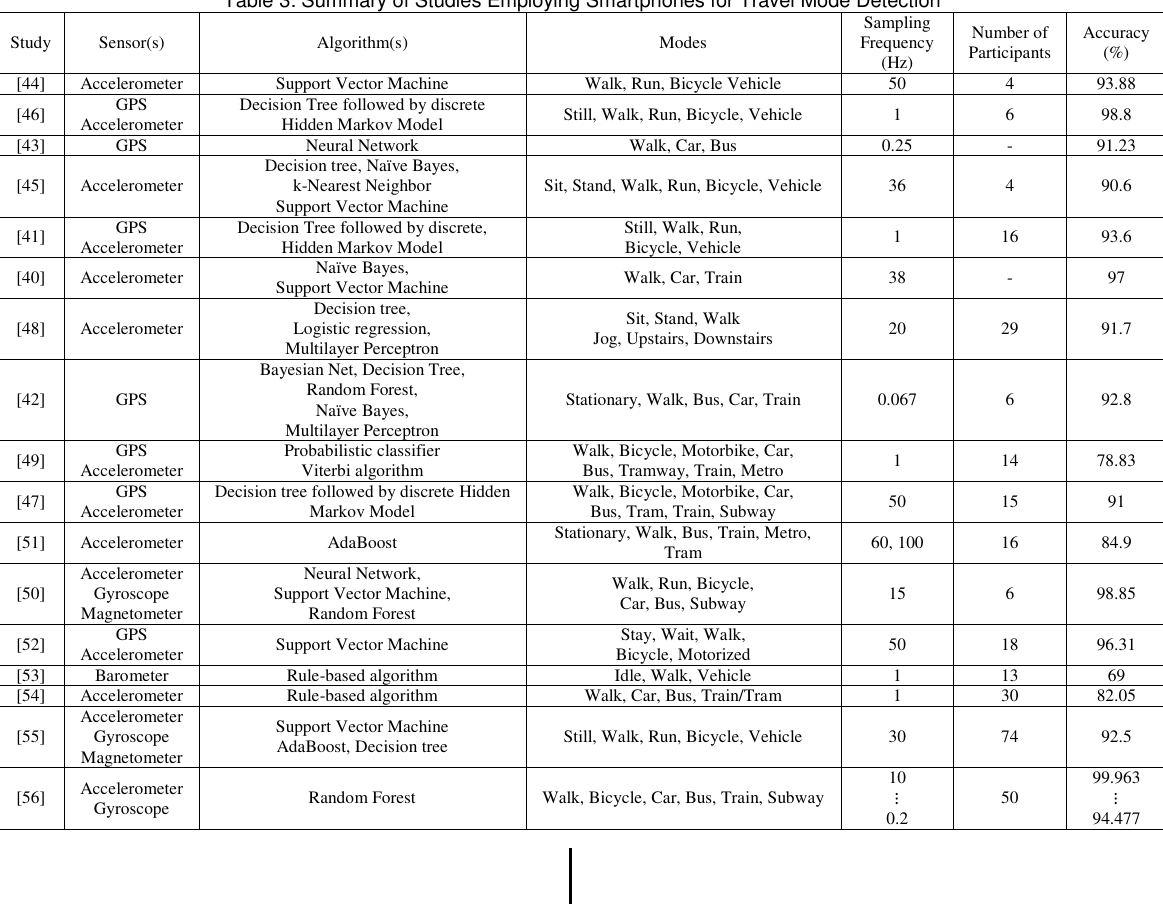
Table 3: Summary of Studies Employing Smartphones for Travel Mode